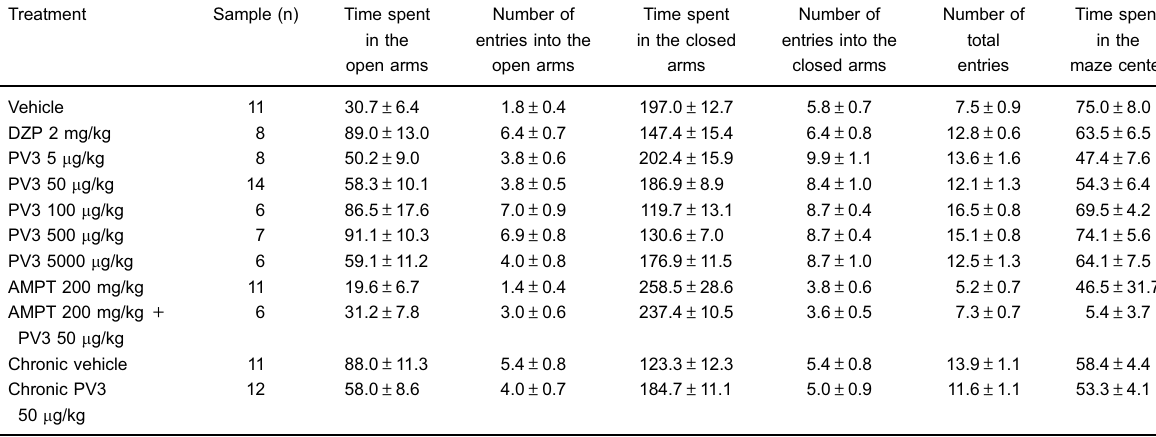
Table 2. Summary of the parameters analyzed in the elevated plus maze experiments.